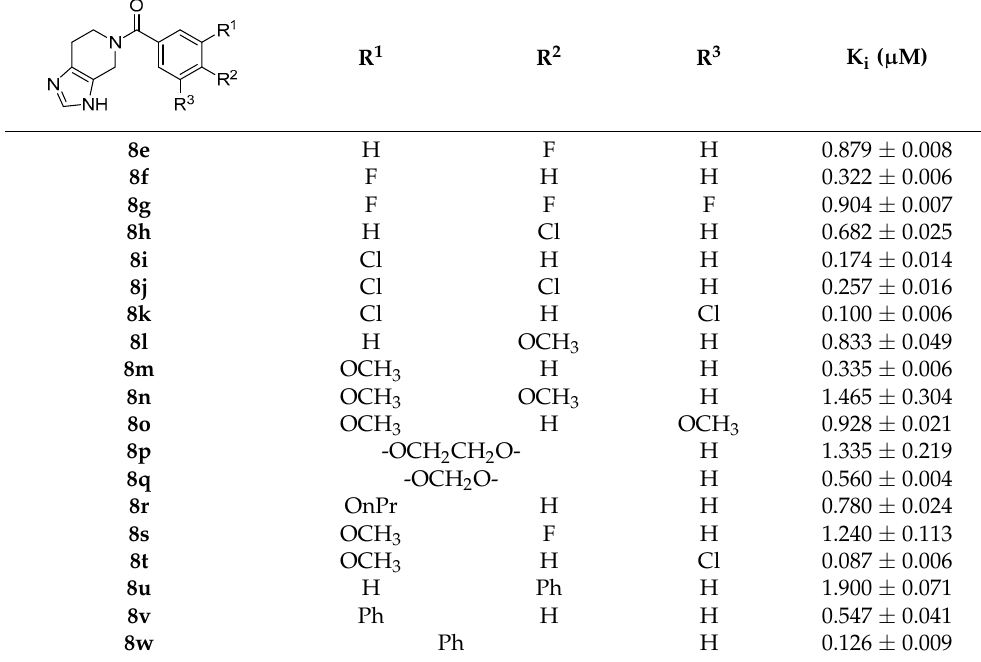
R 1 Table 2. Inhibition of PgQC by N -benzoyltetrahydroimidazo[4,5- c ]pyridines.